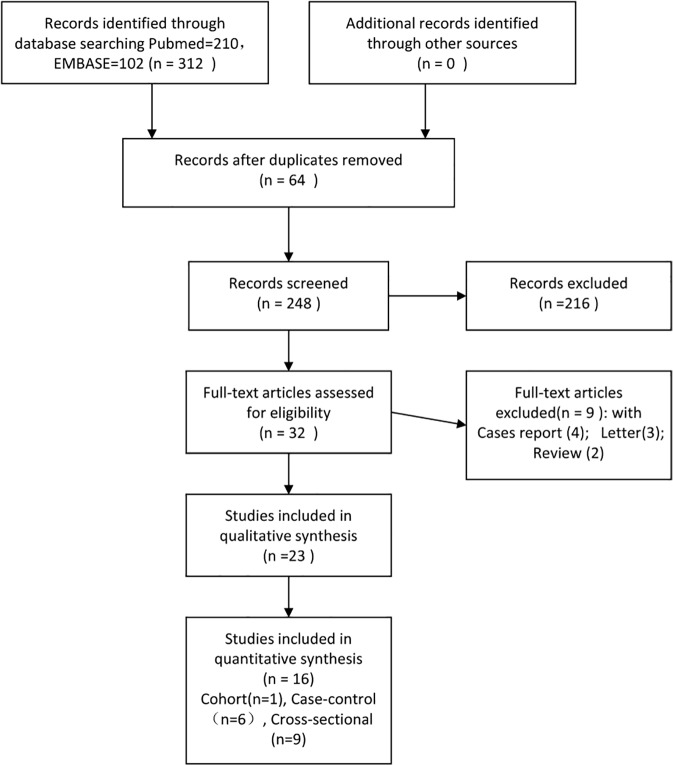
Flow chart of the procedure for identifying studies and the results thereof.